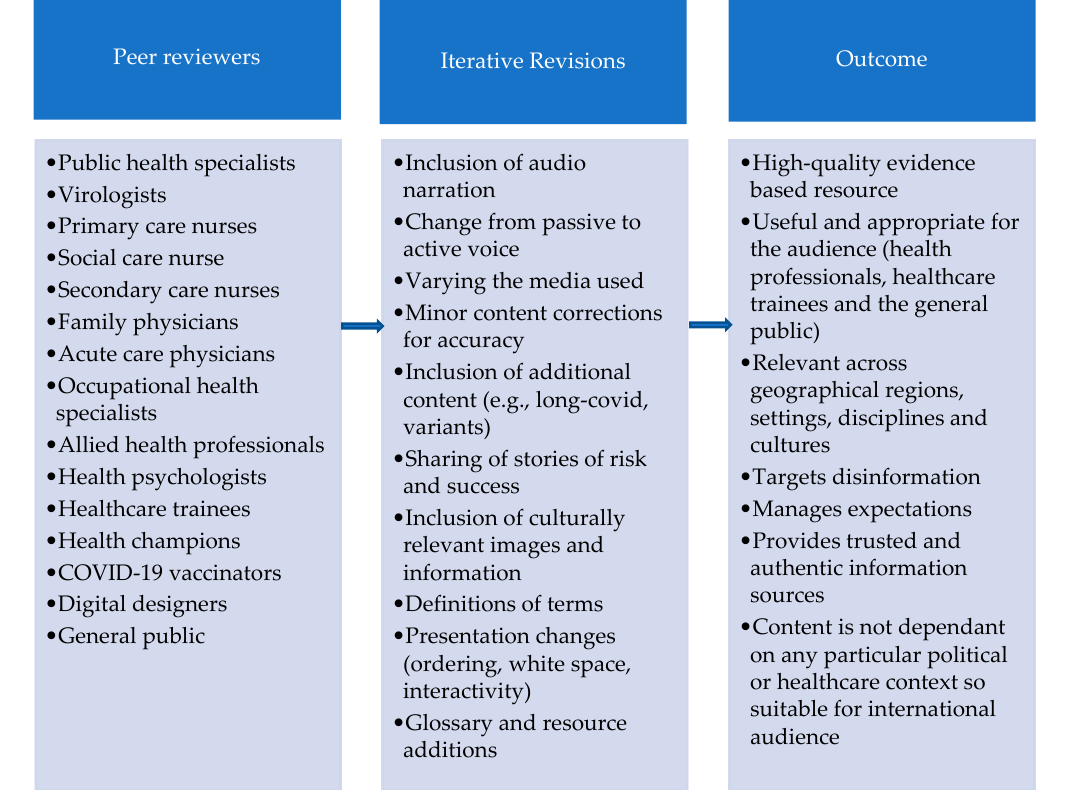
Figure 4. Co-design through expert and lay peer review.